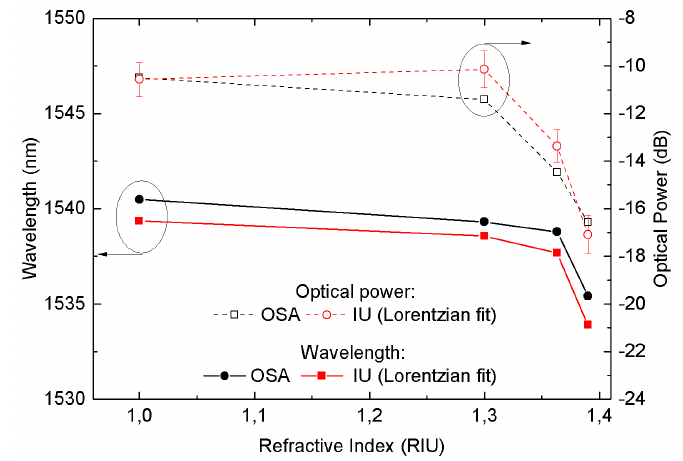
Figure 13. Comparison between the IU with a Lorentzian curve fit and the OSA for the refractive index response of a LPFG peak wavelength and optical power.